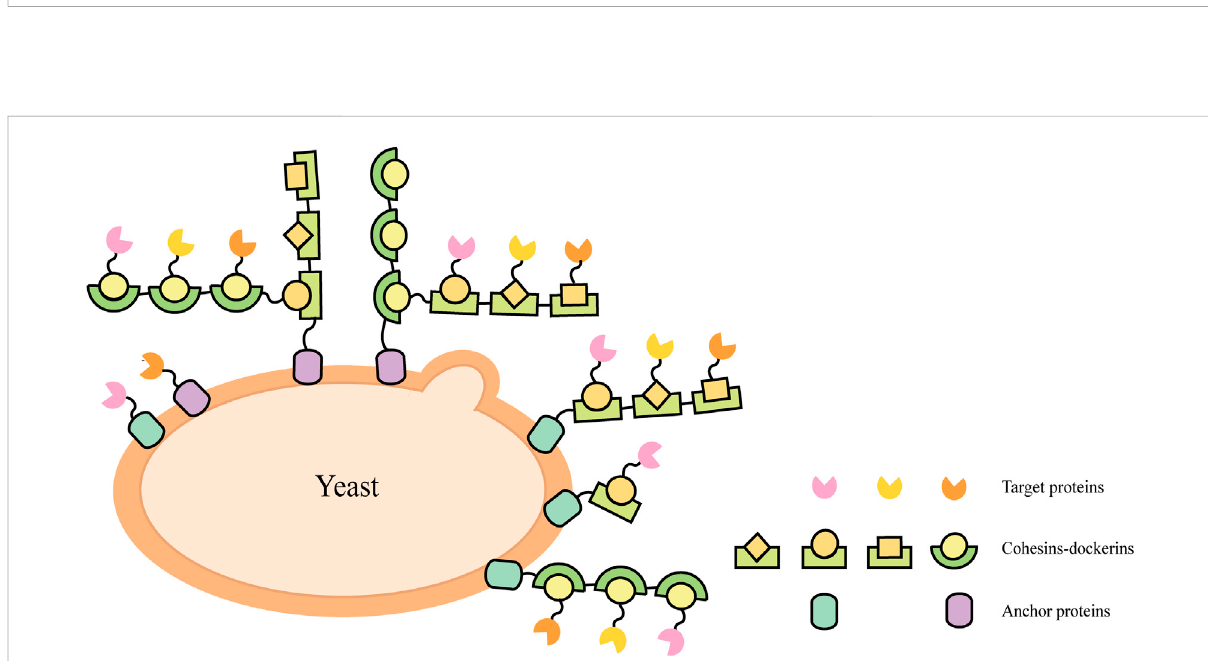
FIGURE 2 Schematic illustrations of direct and indirect cell-surface display strategies in S. cerevisiae